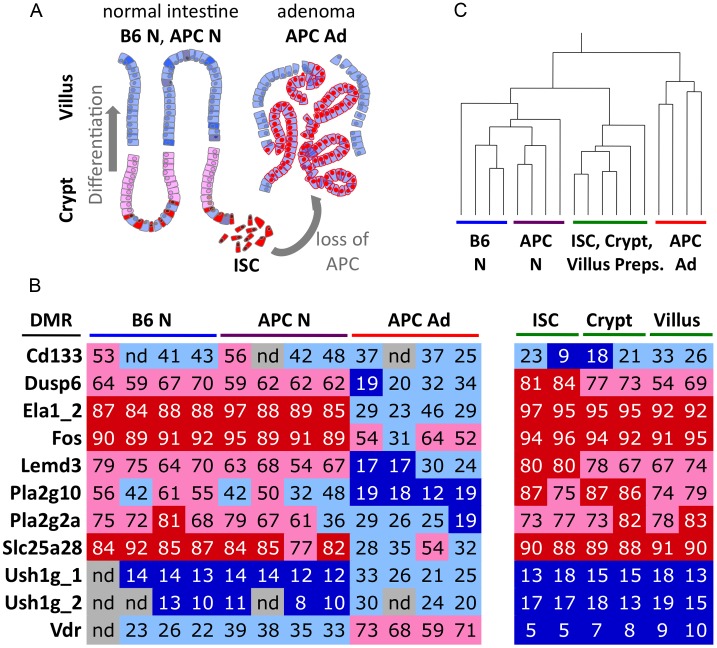
CpG methylation differentiates normal epithelial cell types from adenoma.a) Schematic representation of intestinal tissues and cell types. Differentiated villus cells are the prevailing component of bulk normal tissue samples. b) Colour-coded table of CpG methylation analyses of 11 DMRs, using bisulfite pyrosequencing. Cd133 is an intestinal stem cell and cancer stem cell marker. Dusp6 to Slc25a28 represent adenoma hypomethylated DMRs, Ush1g_1 to Vdr represent adenoma hypermethylated DMRs. Percent CpG methylation within the regions are given as numbers and colour-code. Dark blue, <20% CpG methylation; light blue, 20–50% CpG methylation, light red, 50–80% CpG methylation; bright red, >80% methylation. c) Hierarchical clustering of methylation data (as shown in b) separates adenoma from normal tissue and cell preparations. Pearson correlation was employed.